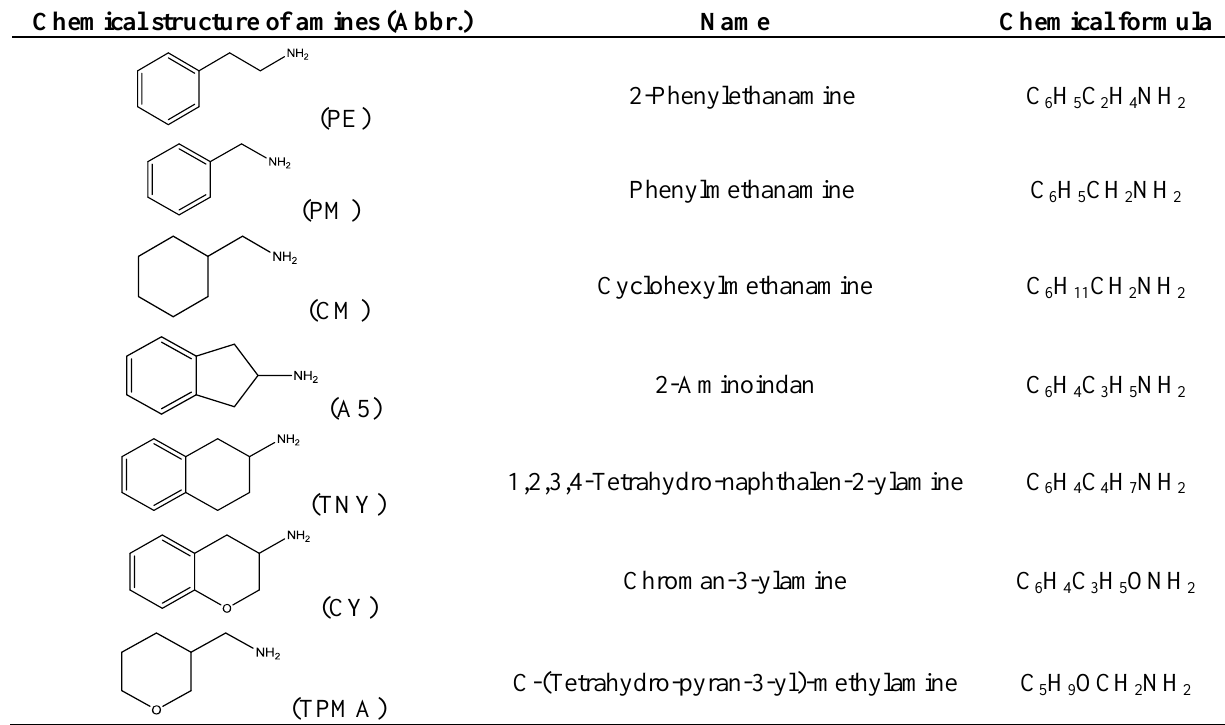
Table 1. Chemical structures, abbreviations, names and chemical equations for the amine precursors of the perovskites. Chemical structure of amines